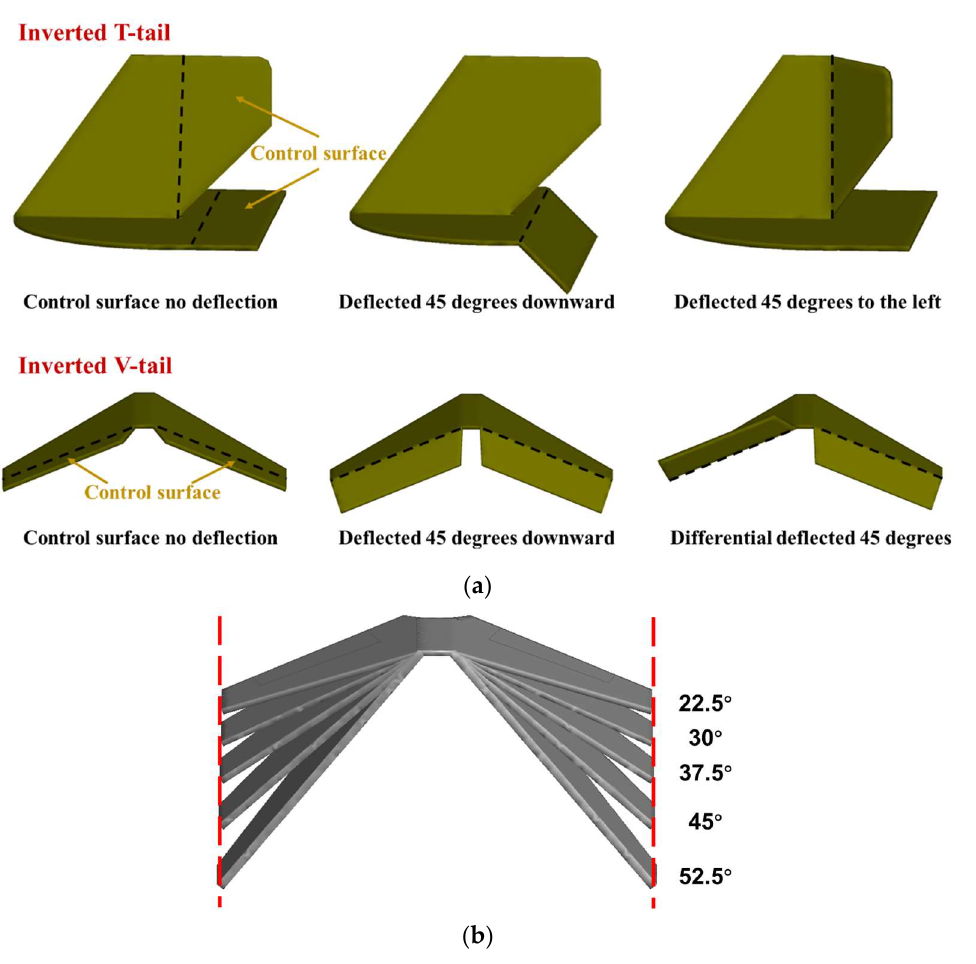
Figure 4. Tail models in the simulation. ( a ) Undeflected and deflected tail control surfaces. ( b ) Inverted V–tail models with different dihedral angles. Table 2. Tail design parameters .